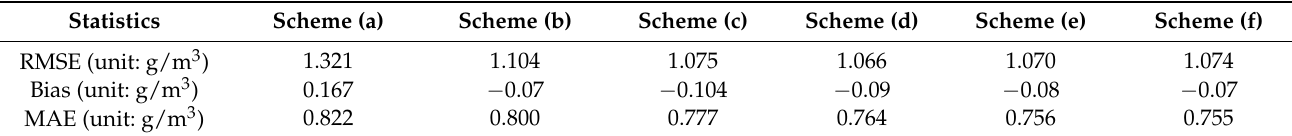
Table 2. Statistical results of the six schemes, with results derived from differences in water vapor density between radiosonde data and tomography.